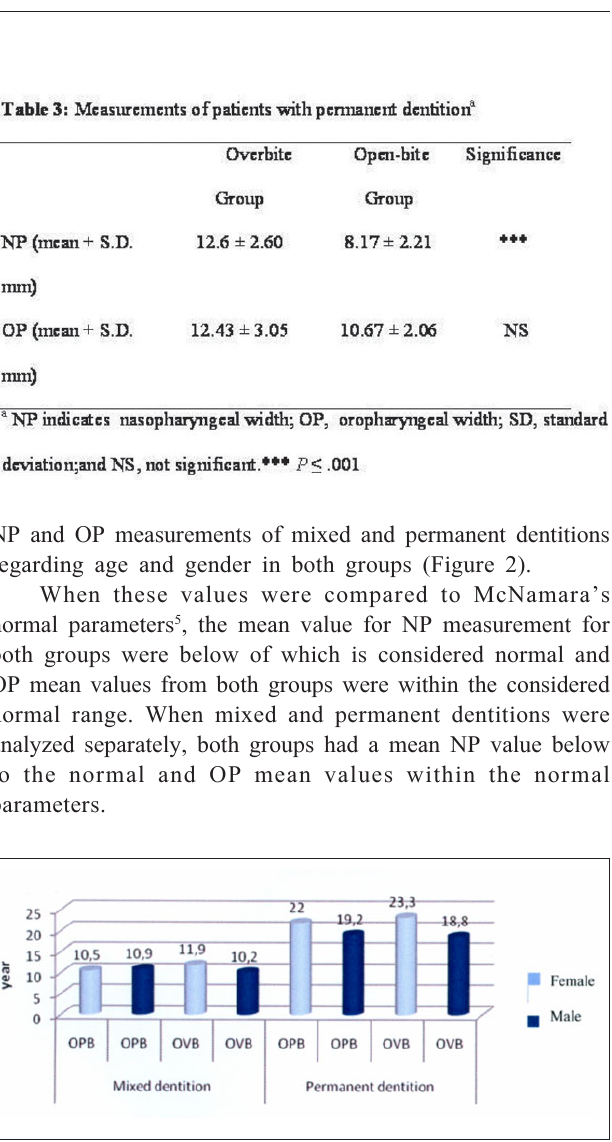
Fig. 2 . Profile of patients with open bite and overbite regarding gender and age. Footnote: OPB- open bite. OVB-